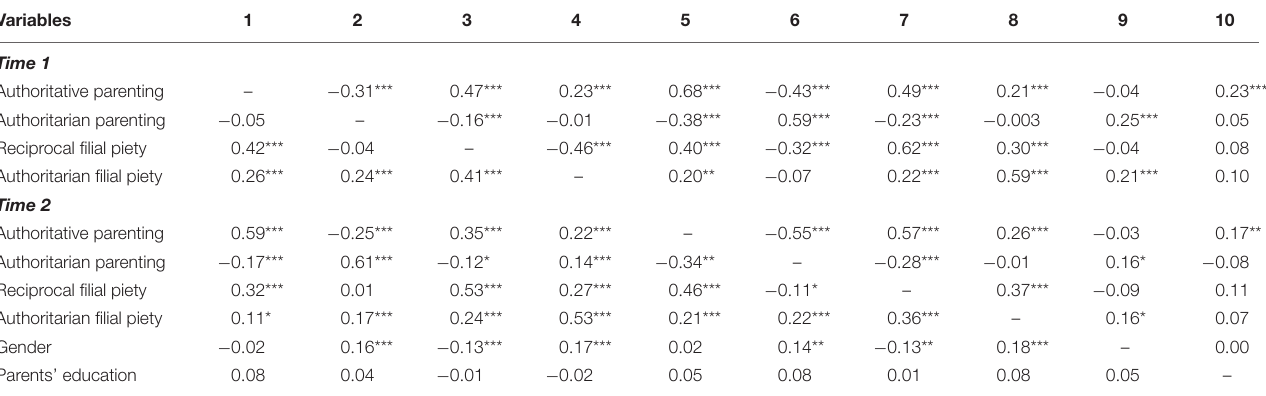
TABLE 3 | Bivariate correlations among the study variables.